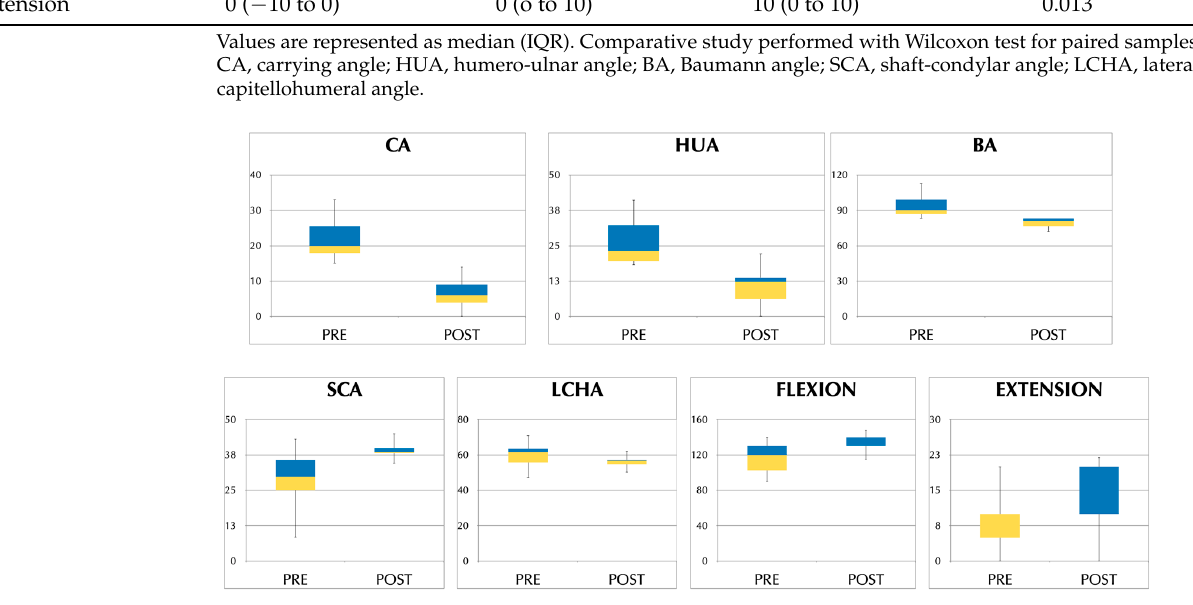
Figure 4. Boxplot representing pre- and postoperative clinical carrying angle (CA), humero-ulnar angle (HUA), Baumann angle (BA), shaft-condylar angle (SCA), lateral capitellohumeral angle (LCHA), and flexion and extension.